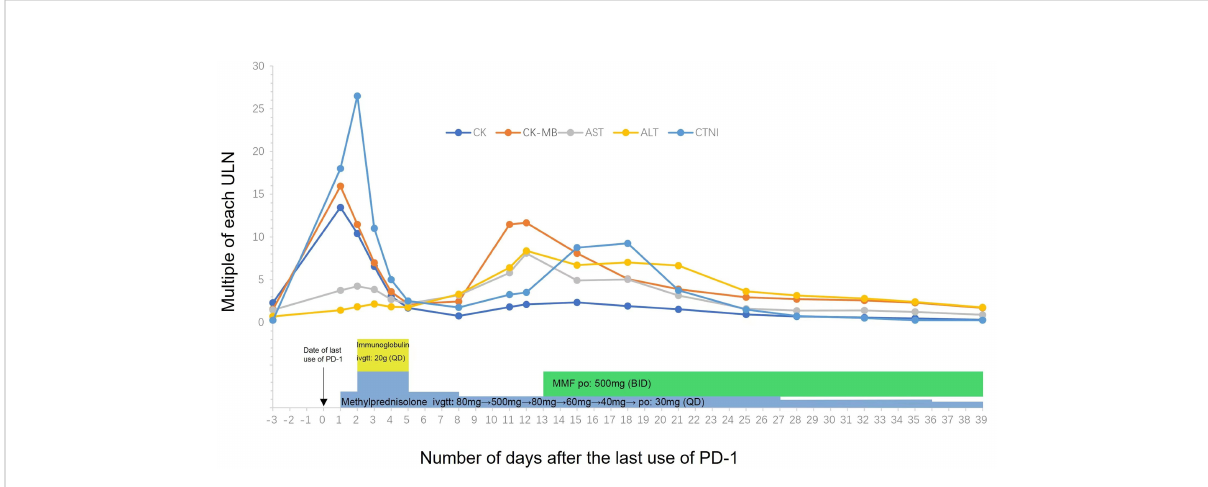
FIGURE 1 Temporal changes of creatinine kinase (CK), cardiac troponin I (cTnI) and myocardial enzyme (AST/ALT/CK-MB). Treatments performed are indicated below the graph. MMF, Mycophenolate